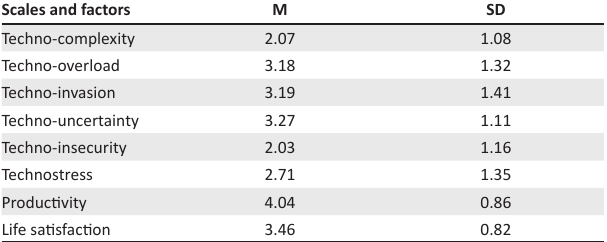
TABLE 3: Mean scores and standard deviations of the scales and factors.